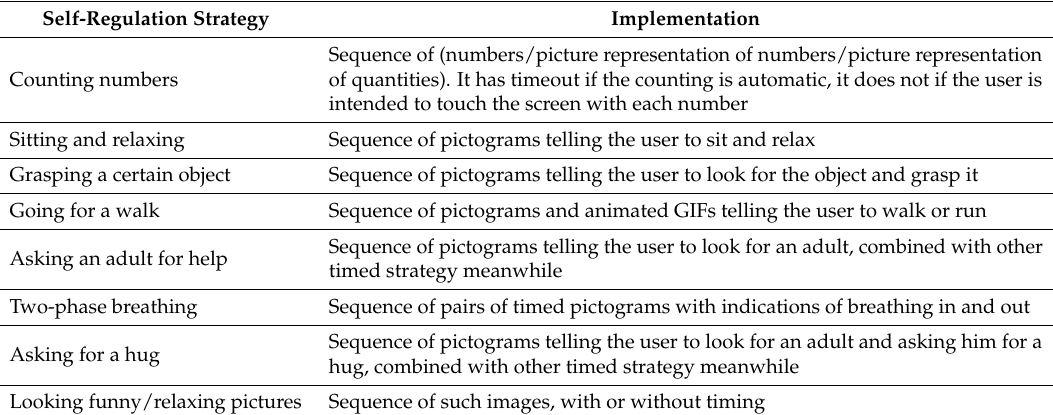
Table 1. Traditional intervention strategies and their implementation in the